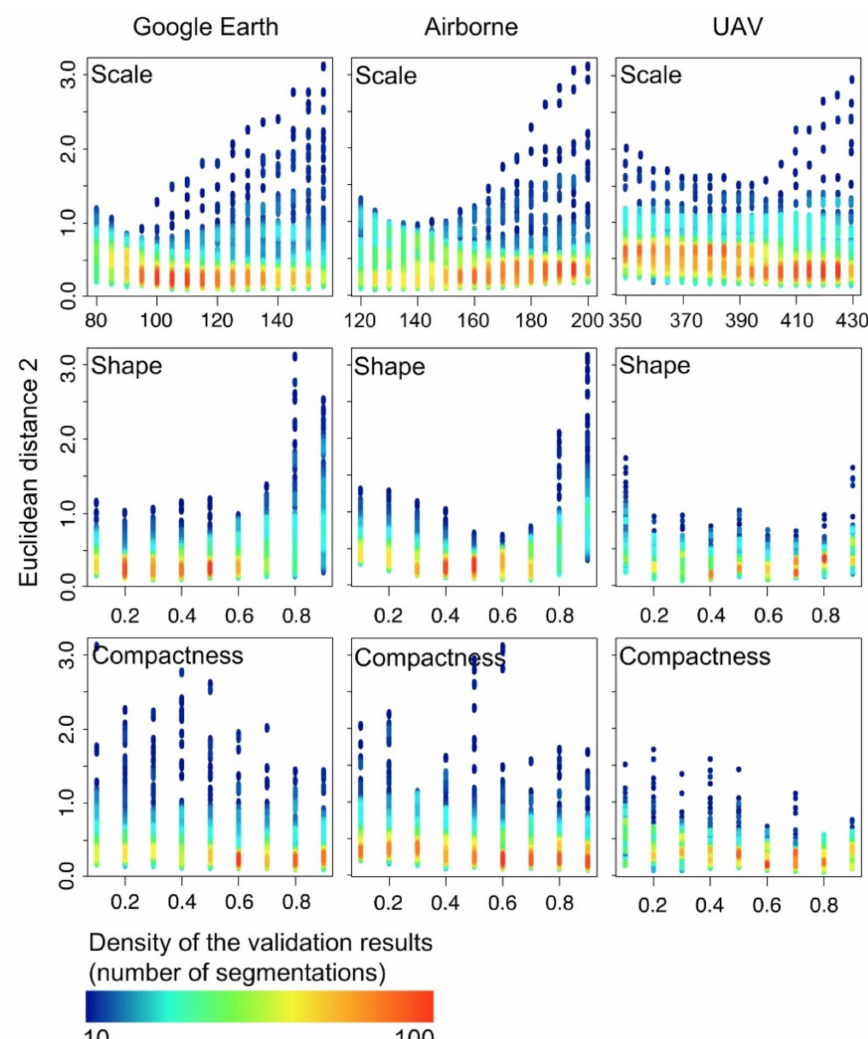
Figure 2. Relationship between Scale, Shape and Compactness parameters (X axis) evaluated using Euclidean distance v.2 (ED2; Y axis) in 9234 Object-based image analysis (OBIA) segmentations from Google Earth, Airborne and unmanned aerial vehicle (UAV) images. The rainbow palette shows the density of validation results. In red high density and in blue low